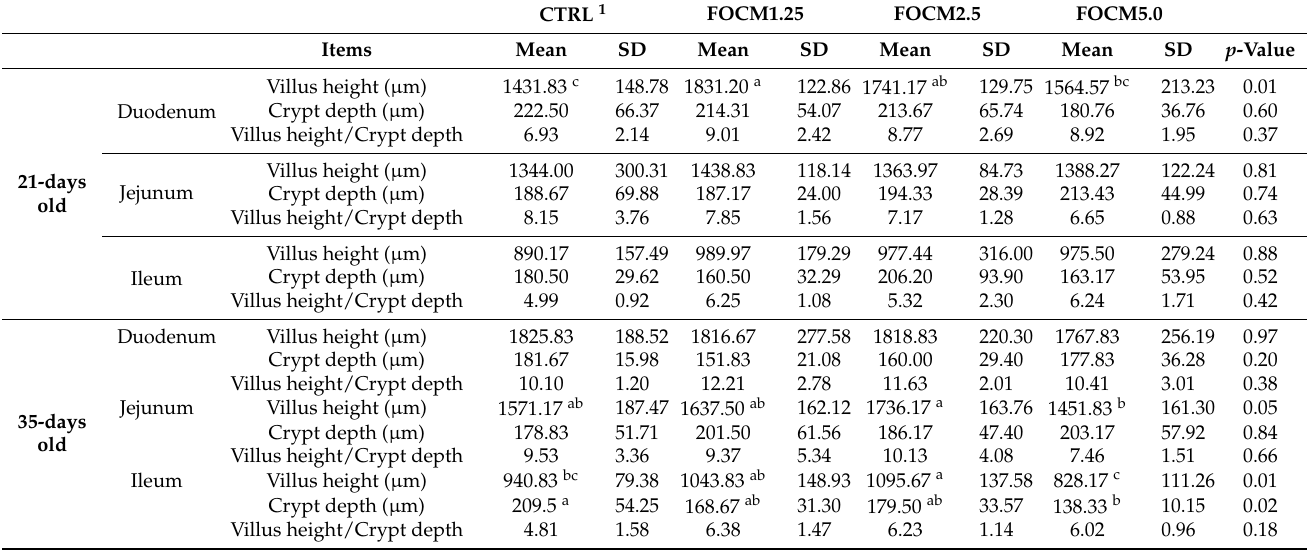
Table 6. Effect of FOCM supplemented in diet on broiler intestinal